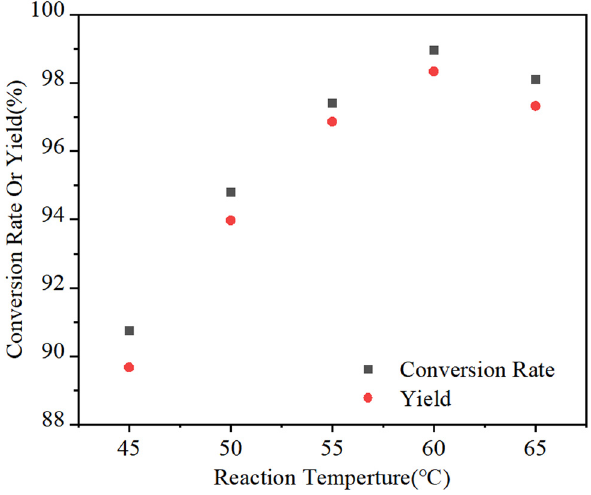
Figure 10: E ff ect of the reaction temperature on the ε - caprolactone yield. Reaction conditions: cyclohexanone ( 0.02 mol ) , benzalde - hyde ( 0.06 mol ) , 1,2 - dichloroethane ( 30 mL ) , Fe – Sn – O ( 0.12 g ) , O 2 ( 20 mL min − 1 ) , 5